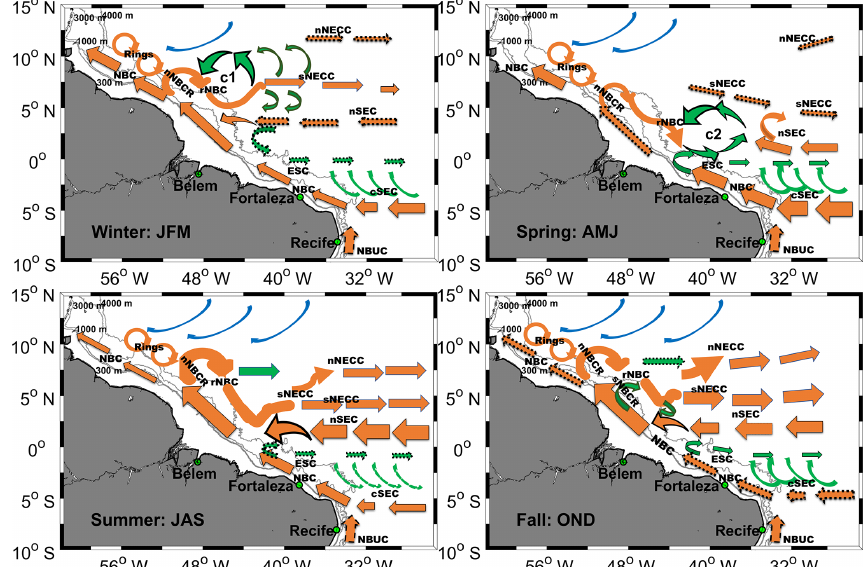
Figure 9. Schematic view of the seasonal maps of the tropical western boundary surface circulation together with the subsurface NBUC signature at the surface. C1 and C2 represent the cyclonic circulations highlighted in this study. The size of the arrows is wider when the intensity of the current is at its maximum (normal arrows) and decreases with season to reach its minimum (thin dotted line). The NBUC is represented because of its contribution to the NBC transport and is shown by dashed arrows. The current branches that are already known are in orange and blue (for the currents fed by Southern Hemisphere and Northern Hemisphere water, respectively). The green arrows characterize the new branches observed. NBC is the North Brazil Current, nNBCR and sNBCR are the northern and the southern flows of the North Brazil Current retroflection, respectively, rNBC is the retroflected branch of North Brazil current, nNECC and sNECC are the northern and the southern branches of the North Equatorial Countercurrent (NECC), respectively, cSEC and nSEC are the central and the northern branches of the South Equatorial Current (SEC), respectively, and ESC is the Equatorial Surface